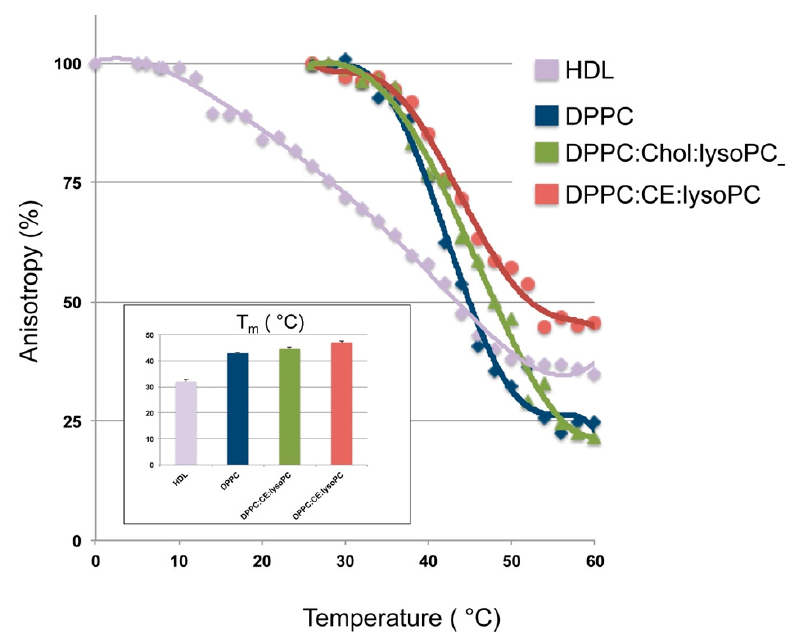
Figure 2. Fluorescence anisotropy of DPH in HDL, DPPC, DPPC:Chol:lysoPC and DPPC:CE:lysoPC rHDLs as a function of temperature. The inflection point of the plot gives the phase transition temperature of high-density lipoproteins (HDL) and rHDLs. Insert shows the phase transition temperatures. DPH was excited at 360 nm and fluorescence anisotropy was measured at 428 nm. All measurements were carried out in TEN buffer pH 8. Concentration of HDL and rHDL was kept constant at apoA-I 2 µM for all measurements. Data points shown are means ± S.D. of at least three independent measurements. DPH: 1,6-diphenyl-1,3,5-hexatriene.